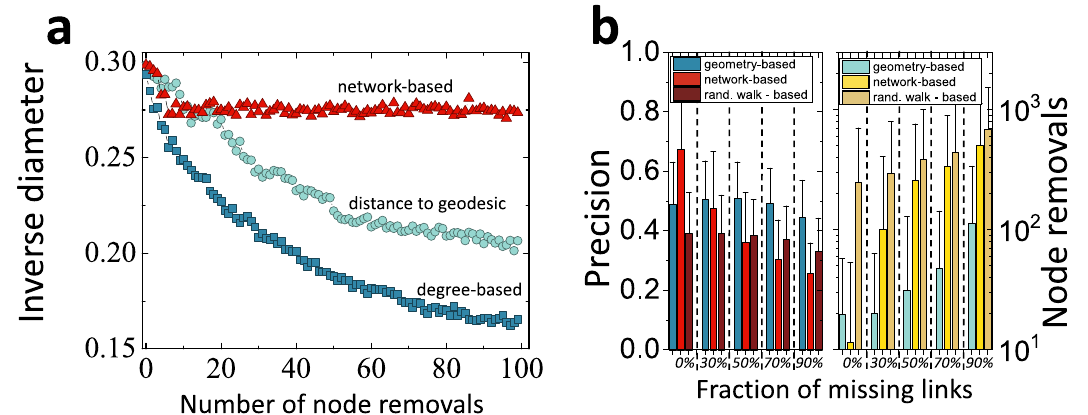
Fig. 2 | The accuracy of nearly shortest path fi nding in the AS Internet. a The average inverse network-based distance between the Autonomous System (AS) node pairs as a function of the number of removed nodes. The average inverse distanceforeachdatapointisestimatedover1,000randomlyselected nodepairs. The averageinverse distanceserves asthe measureof the collateral damageto the network: the smaller is the value, the larger are the network-based distances between nodes. We consider three node removal strategies: (i) nodes with the largest degree, (ii) nodes with the smallest hyperbolic distance to γ ( AS 5392, AS 8875) geodesic,and (iii) nodes with the smallest network-based distances to the AS5392-AS8875 pair.The largestdegree strategyisthe mostinvasive,resulting ina